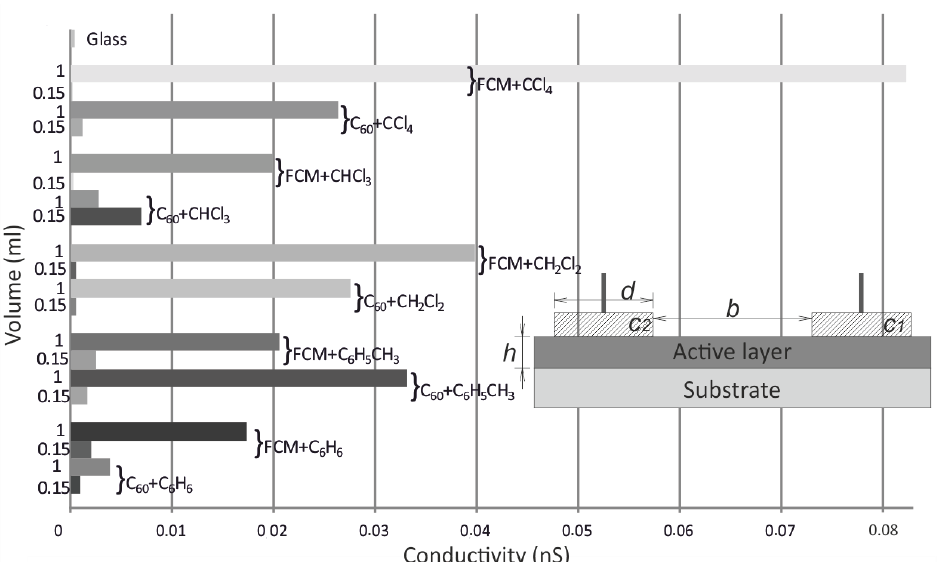
Fig. 4. The comparison of conductivity for FCM and C 60 films deposited from various solvent